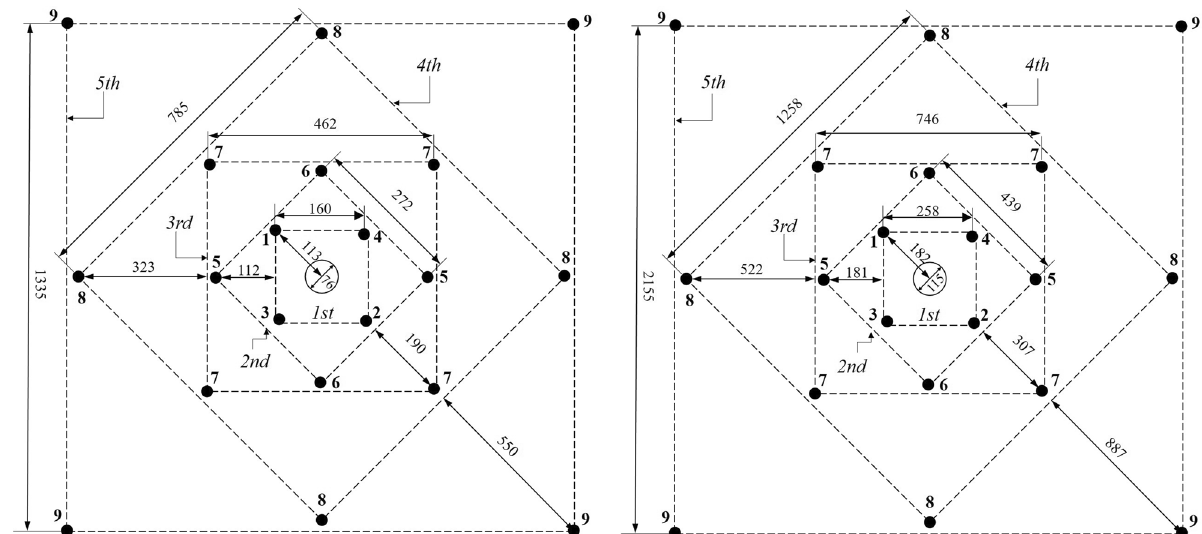
Figure 9. The arrangement of cut holes for 76 and 115 mm empty hole diameters.